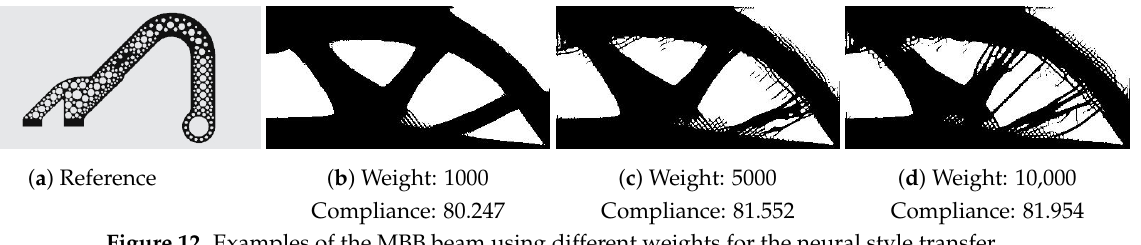
Figure 11. Examples of the cantilever beam using different layers of the neural network.